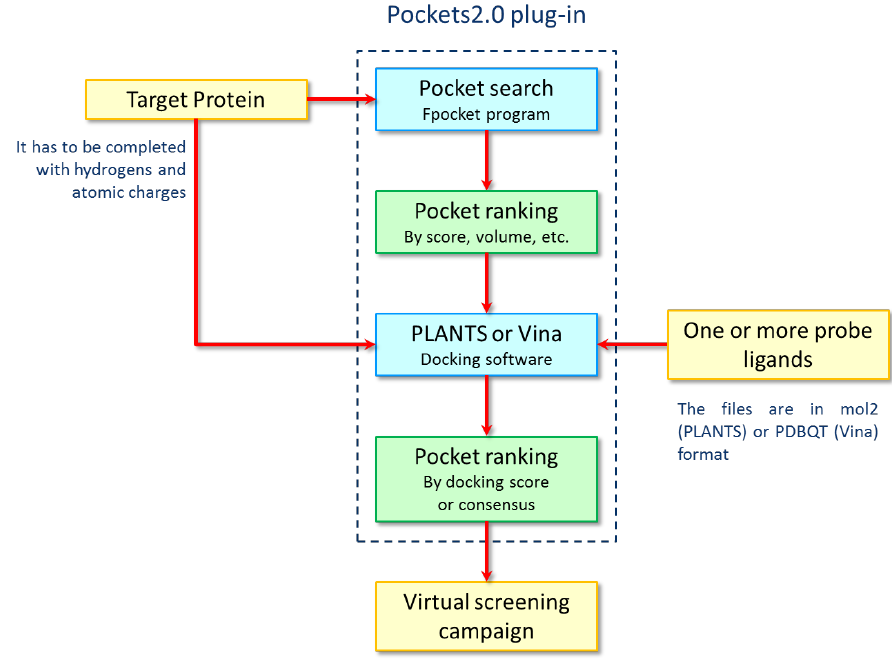
Figure 3. Flowchart describing the main logical steps implemented by Pockets 2.0 to identify and to evaluate druggable protein cavities. evaluate druggable protein